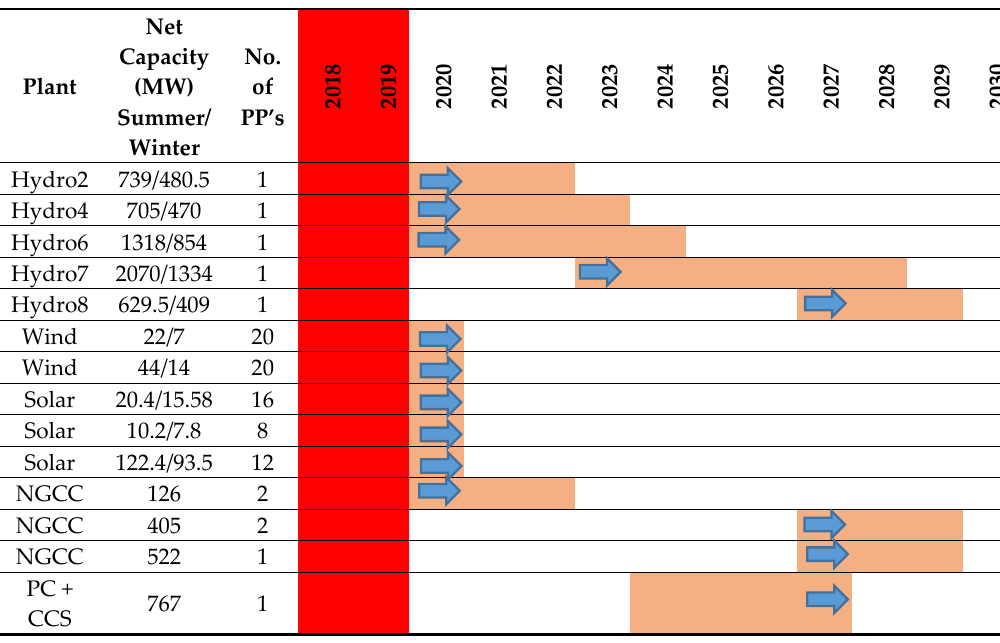
Table A6. Details of the Plants Installation under Capacity Expansion: Normal GDP Fuel Balancing (1–10% Mitigation).